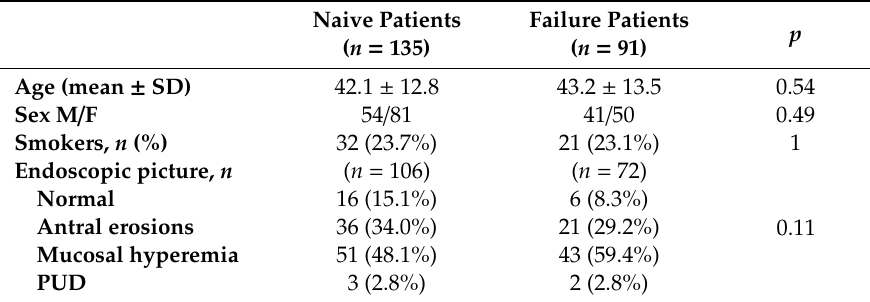
Table 1. Demographic and pathologic endoscopic features in the enrolled population.